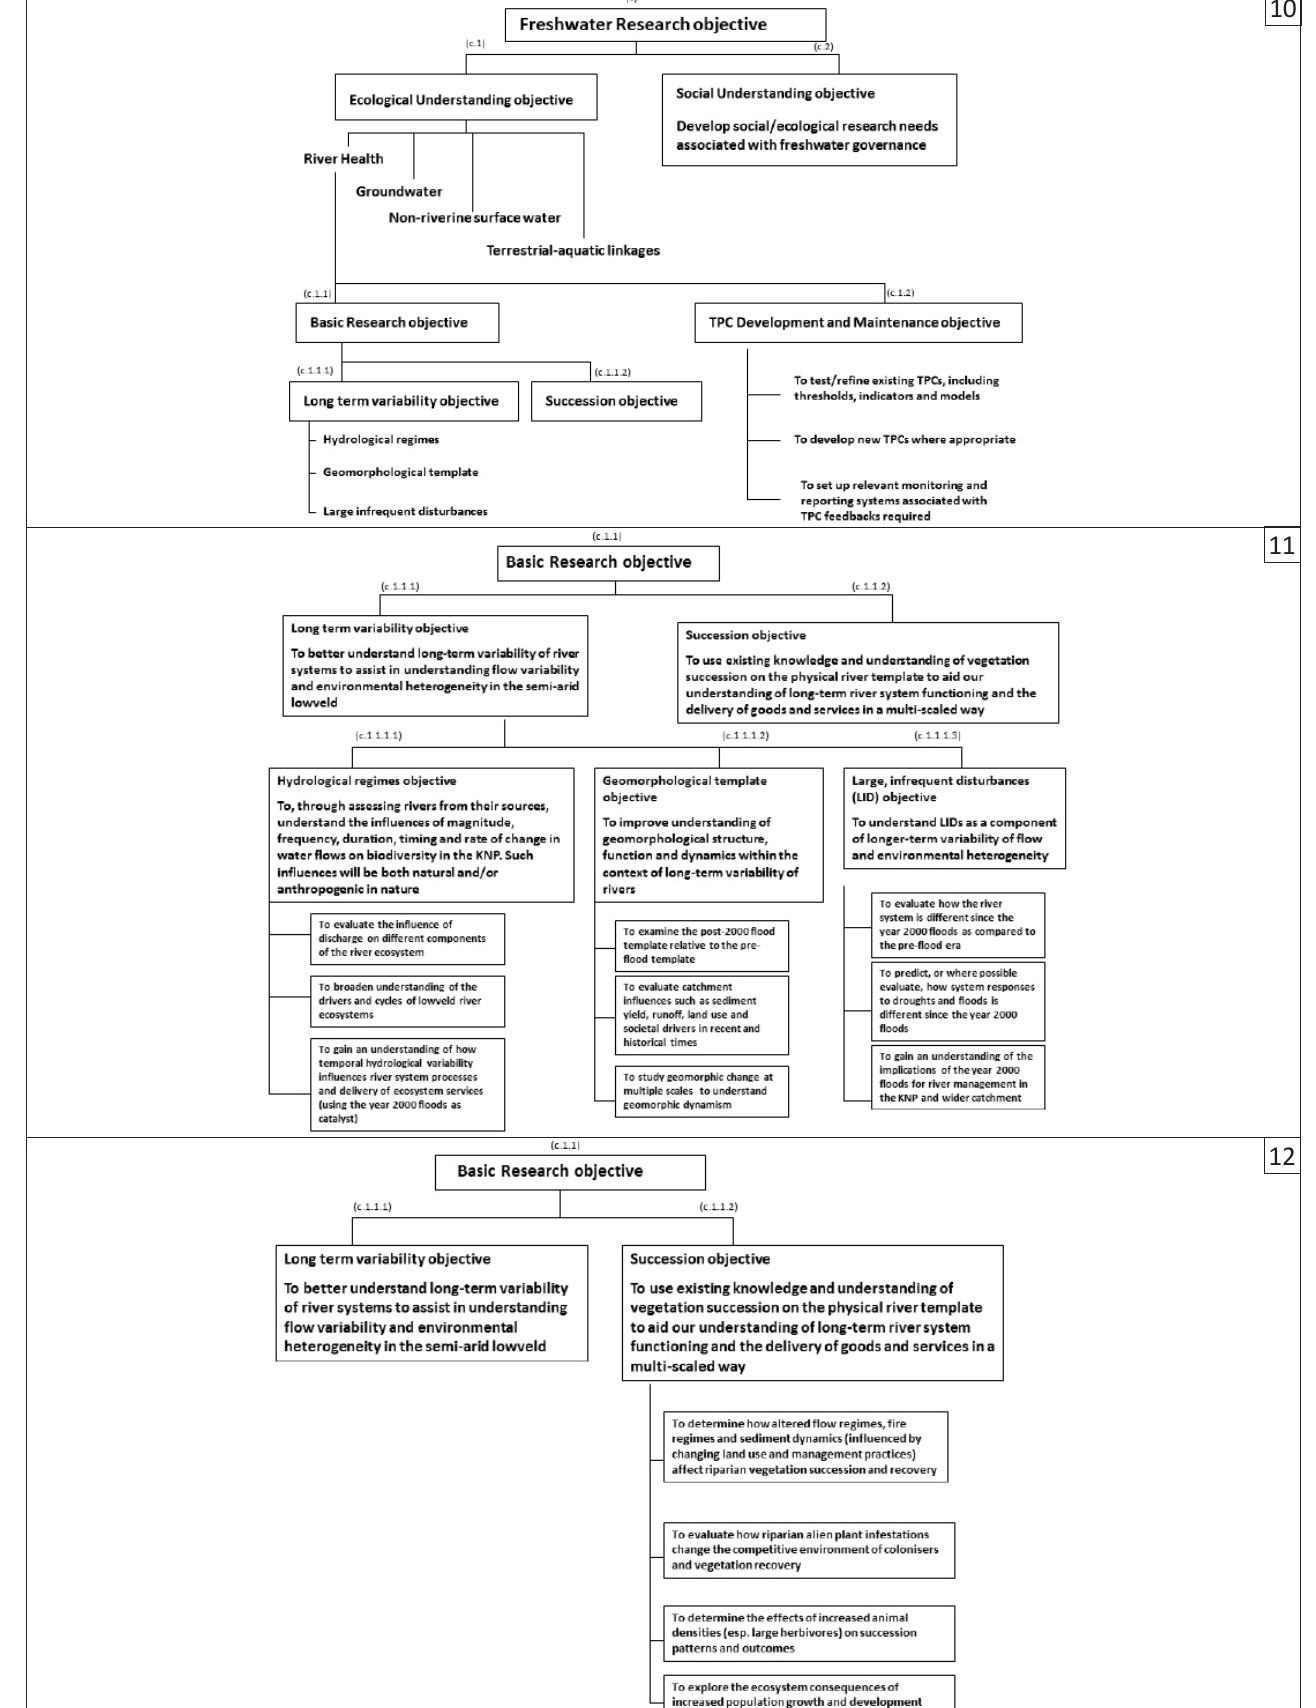
FIGURE 6 (Continues...): Recommended re-structuring related to the river-associated objectives. Figure 6 continues on the next page